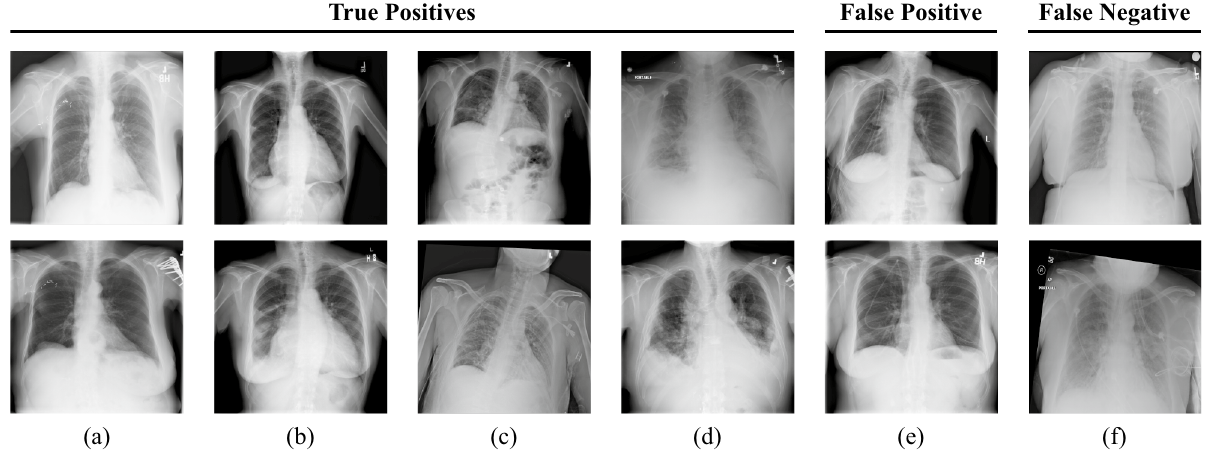
Figure 5. Exemplary image pairs are classified by our best performing verification model. Each column represents one image pair. The first four columns ( a – d ) show true positive classifications. The last two columns ( e ) and ( f ) depict a false positive and a false negative classification,